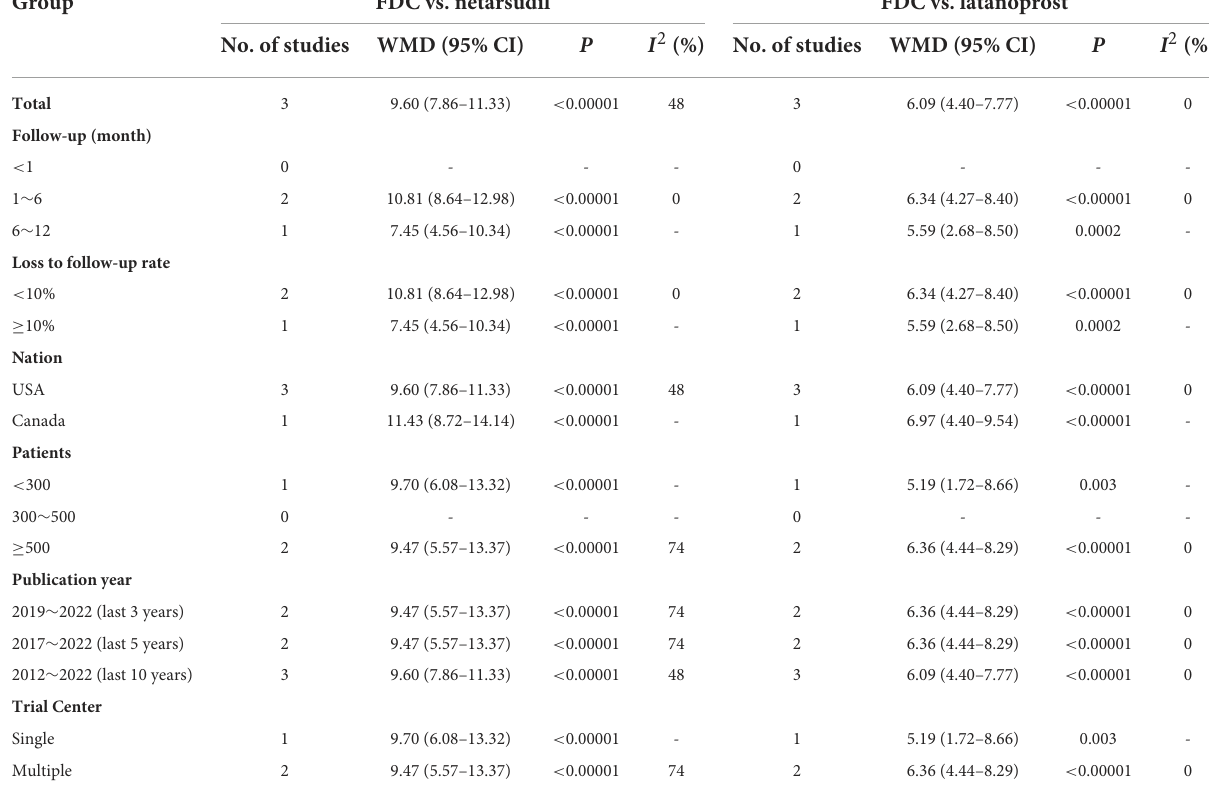
TABLE 2 Subgroup analysis for percentage intraocular pressure reduction